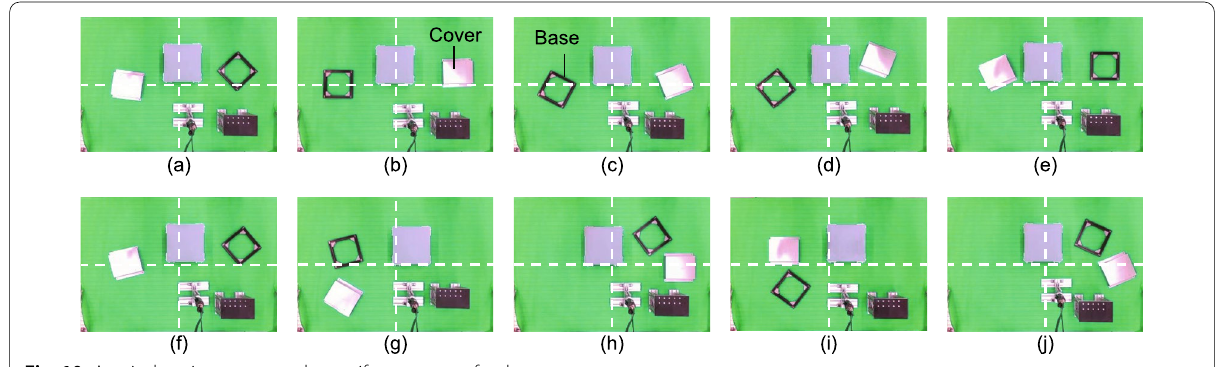
Fig. 10 Atypical environment used to verify sequence of